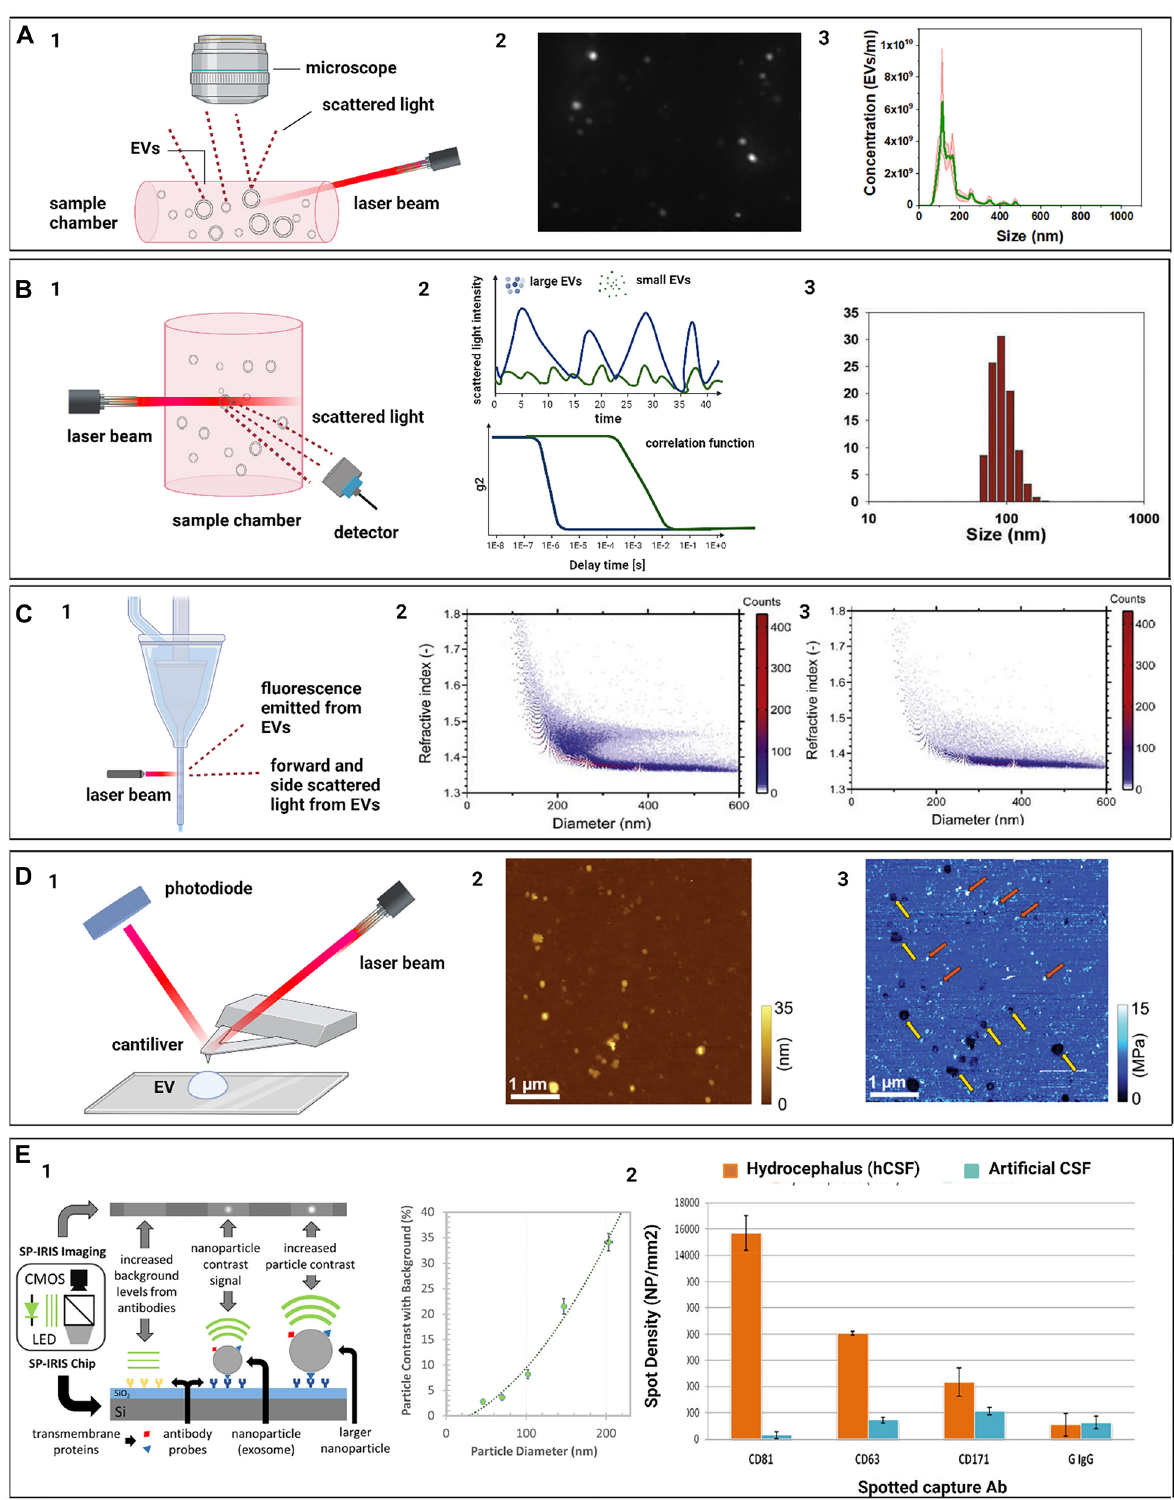
Figure 3: Label-free optical methods for EVs physical characterization. (A) Nanoparticle tracking analysis; (A1) basic setup of the NTA measurement system; (A2) typical micrograph of EVs in the imaging chamber; (A3) graphical representation of NTA histogram of neuronal EVs (adapted with permission from [64]). (B) Dynamic light scattering; (B1) schematic of the optical con fi guration; (B2) representation of DLS results of scattering of small and large EVs, and their correlation